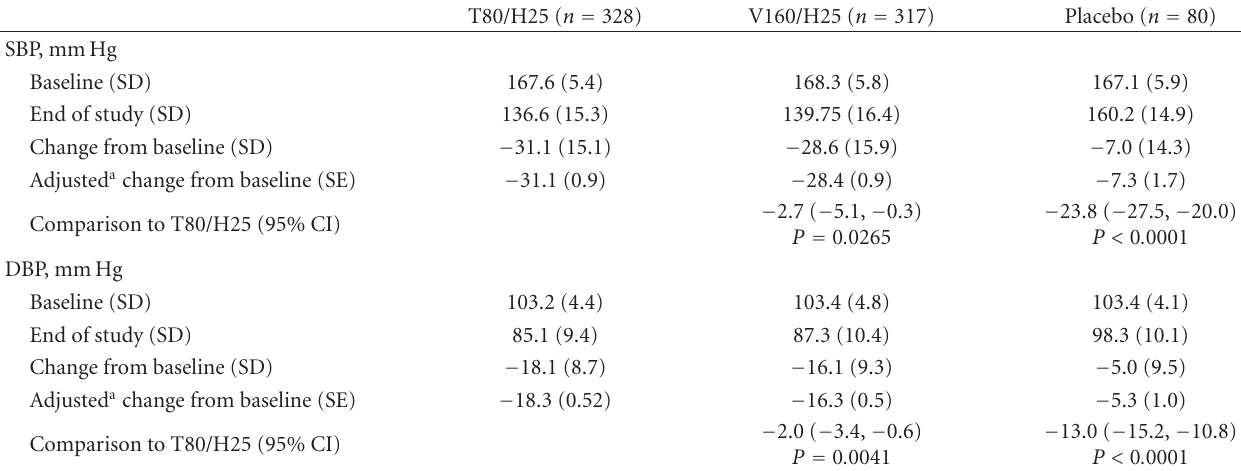
Table 2: Mean seated clinic trough BP and changes from baseline by treatment group.